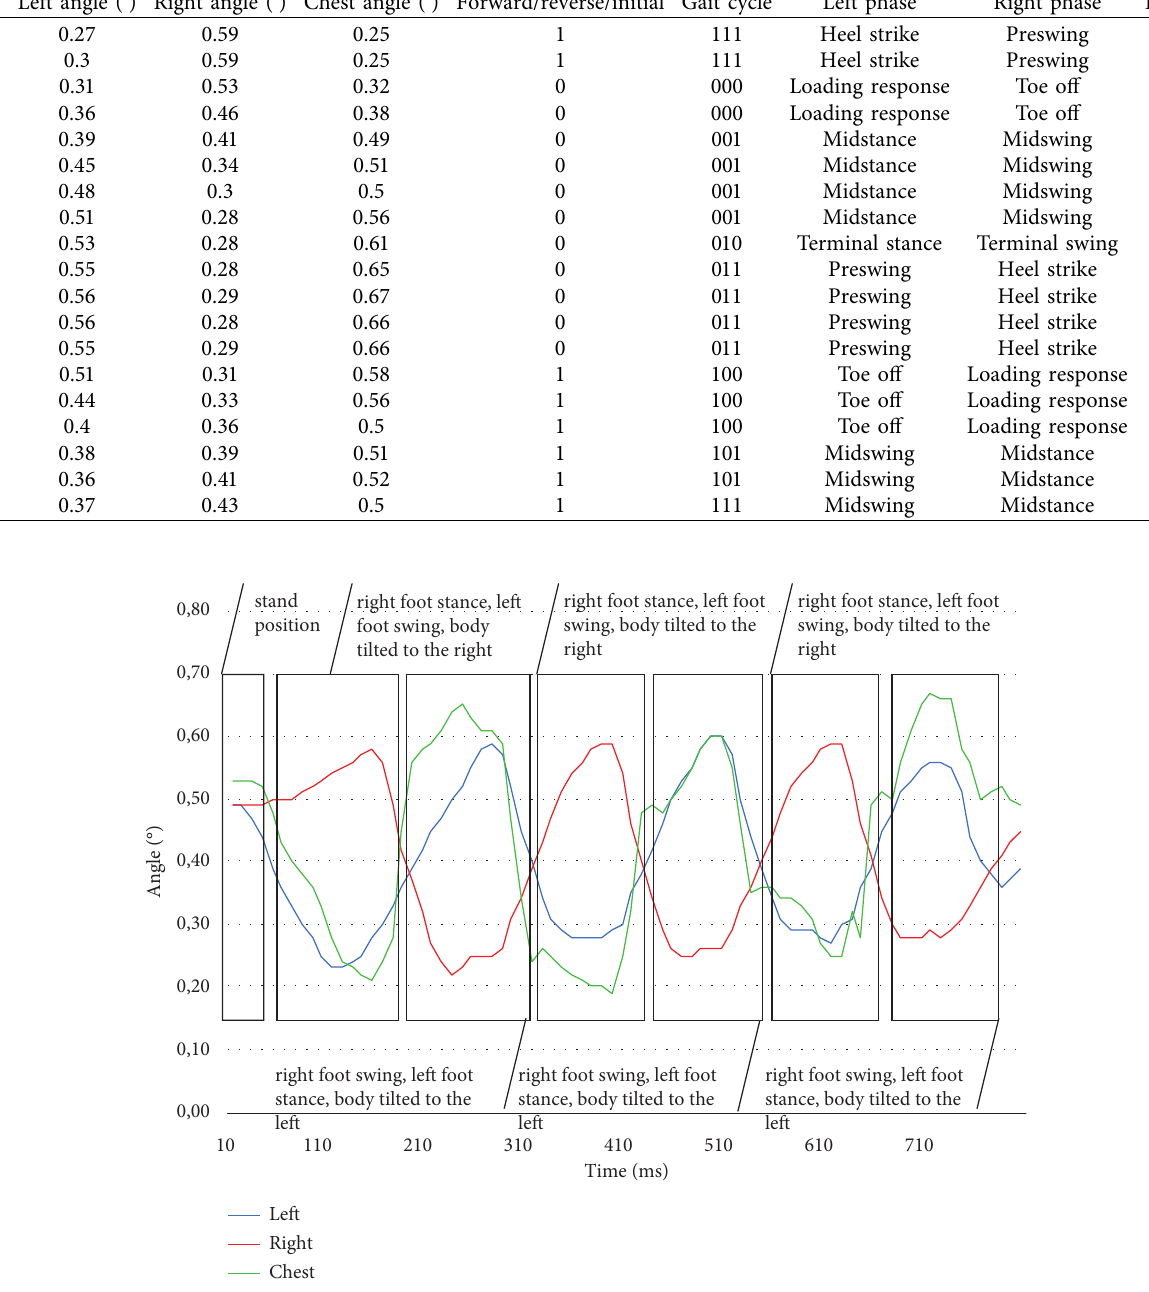
Figure 9: Complete signal representing a normal human walking